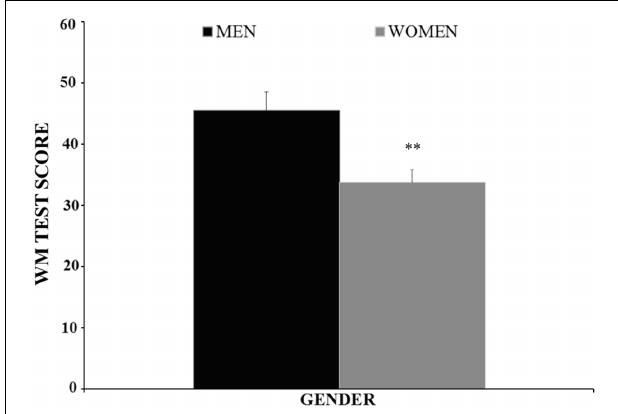
FIGURE 4 | Performance of the Working Memory task (Mean ± SEM) by male and female adolescents. ∗∗ p < 0.01 versus